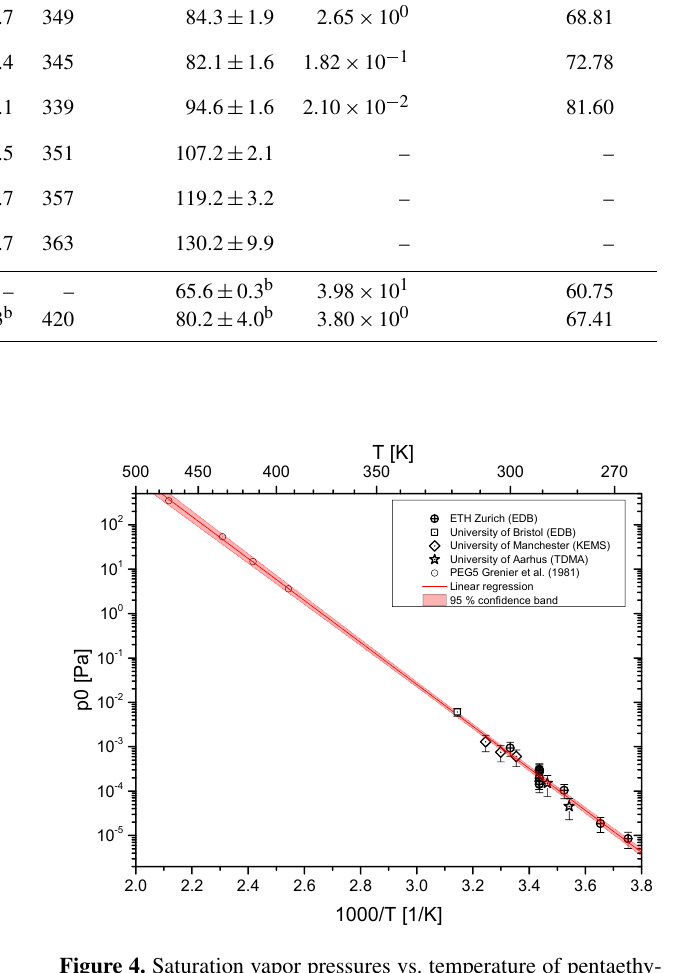
Figure 4. Saturation vapor pressures vs. temperature of pentaethy- lene glycol (PEG5). Symbols as in Fig. 2.